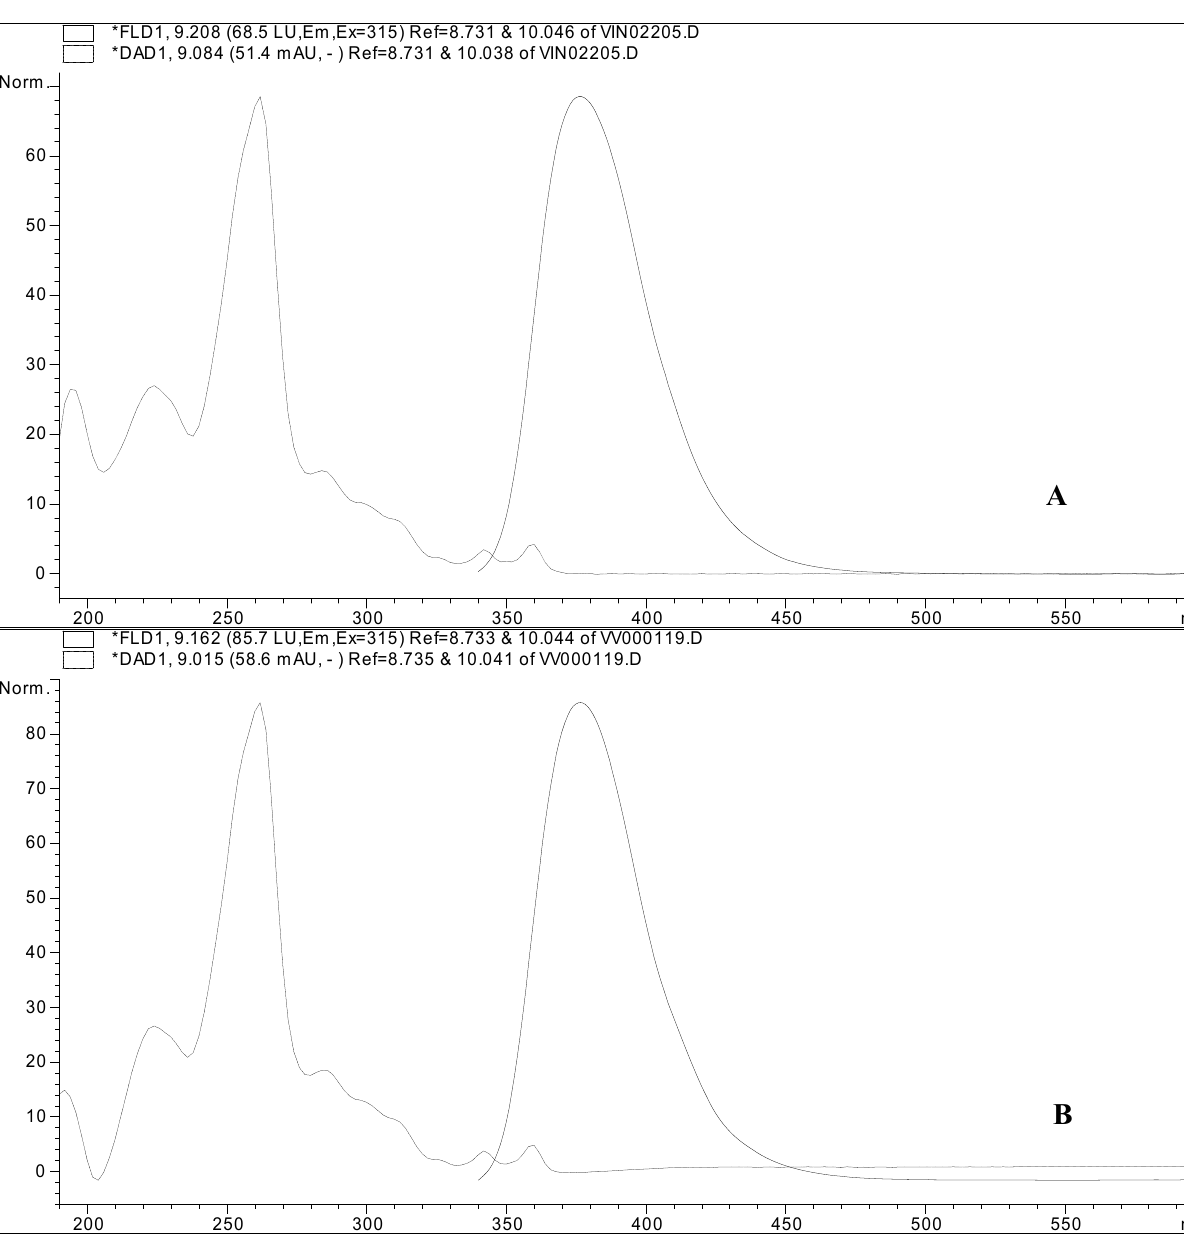
Figure 4. ( A ) UV spectrum of irradiated trans- piceid standard (dashed line) and its emission spectrum (solid line). ( B ) UV spectrum of the Alibernet variety leaves extract (dashed line) and its emission spectrum (solid line), which is peak X in the chromatogram shown in Figure